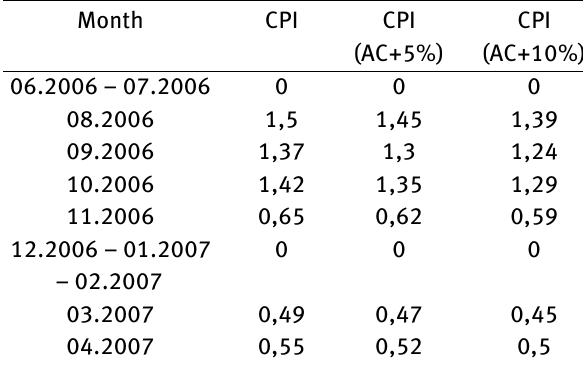
no work was planned. As shown in Table 1, the analyzed project was over budget and behind schedule.